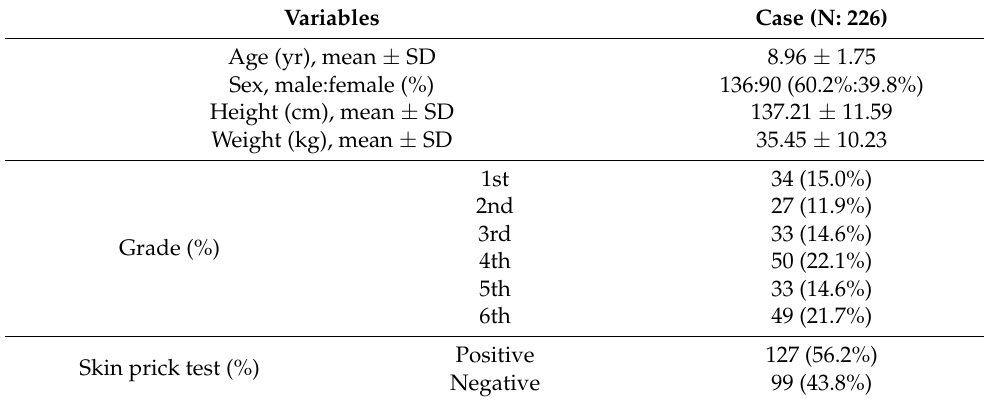
Table 1. General characteristics of the study